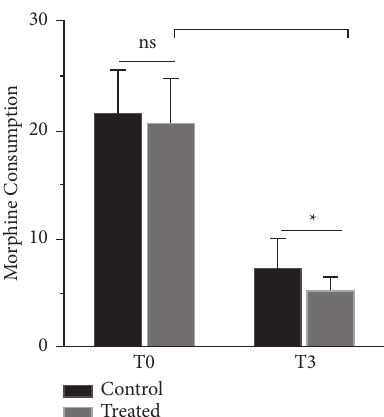
Figure 5: Comparison of morphine consumption in the two groups, ∗ P < 0 . 05. Compared with before surgery, # P < 0 .